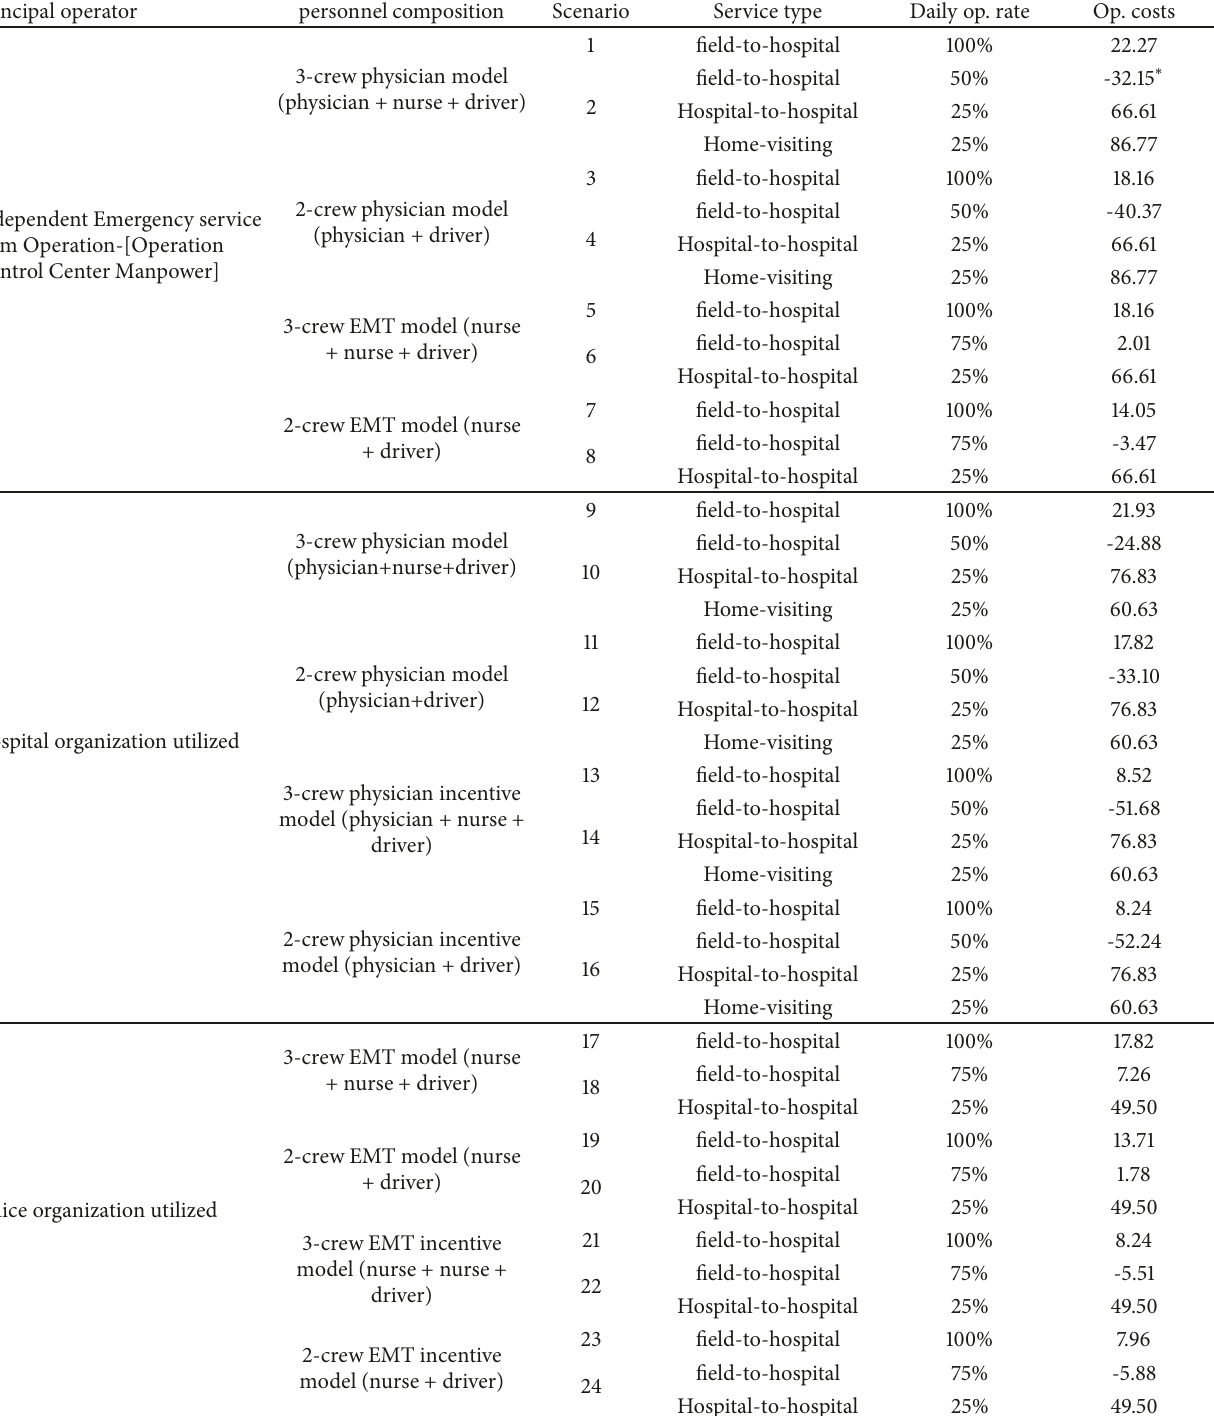
Table 4: Analysis of prehospital emergency medical services based cost-service (units: